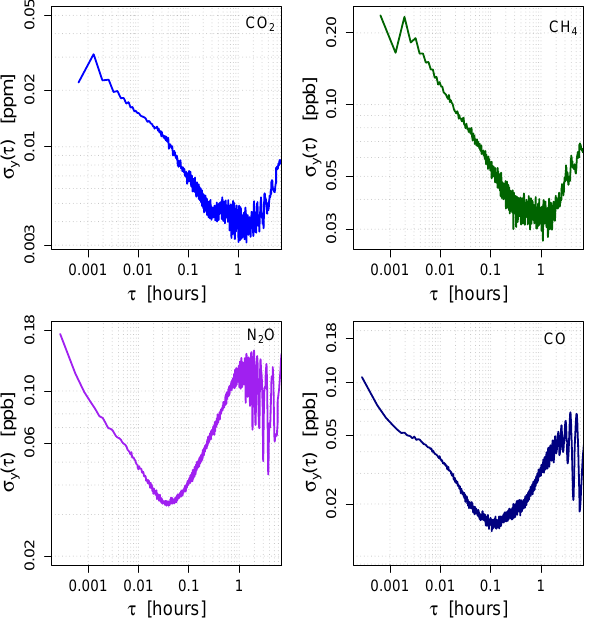
Figure 3. Log–log plots of the Allan deviations of the output of the CRDS and OA-ICOS instruments as they received gas flow from a working tank for 24h.